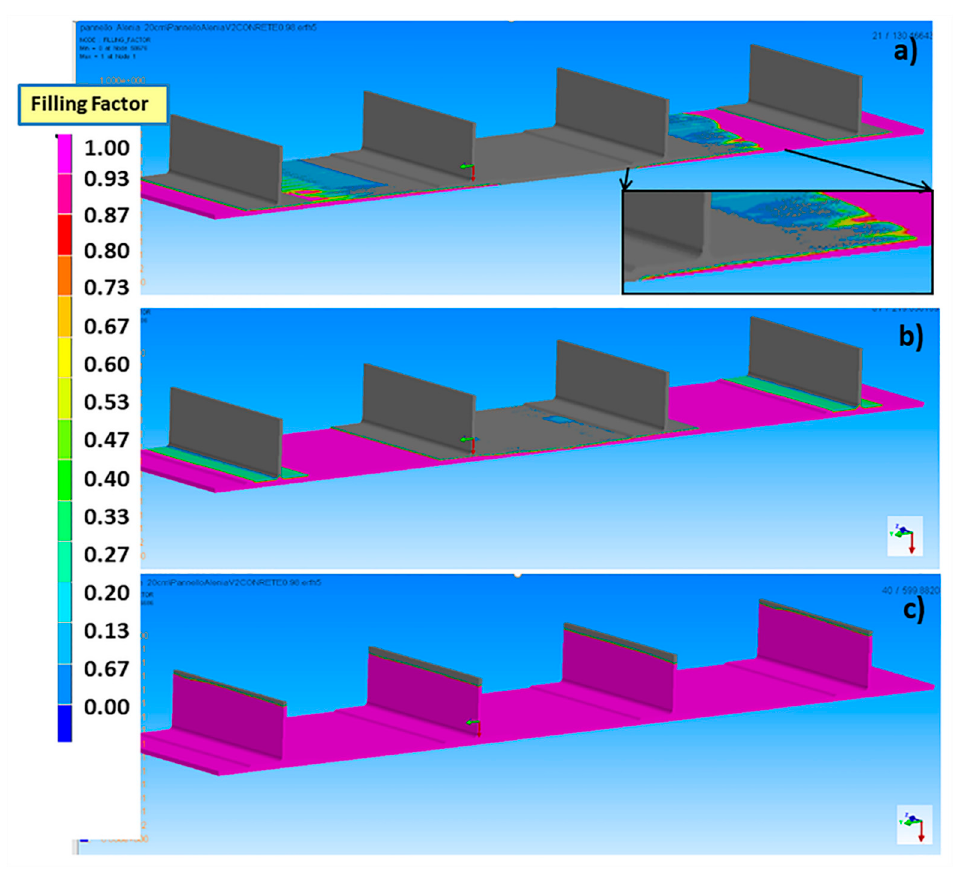
Figure 11. Different filling stages of the stiffened panel at 100 °C and 0.98 bar for different times: ( a ) 130 s, ( b ) 220 s, ( c ) 700 s. ( a ) 130 s, ( b ) 220 s, ( c ) 700 s.